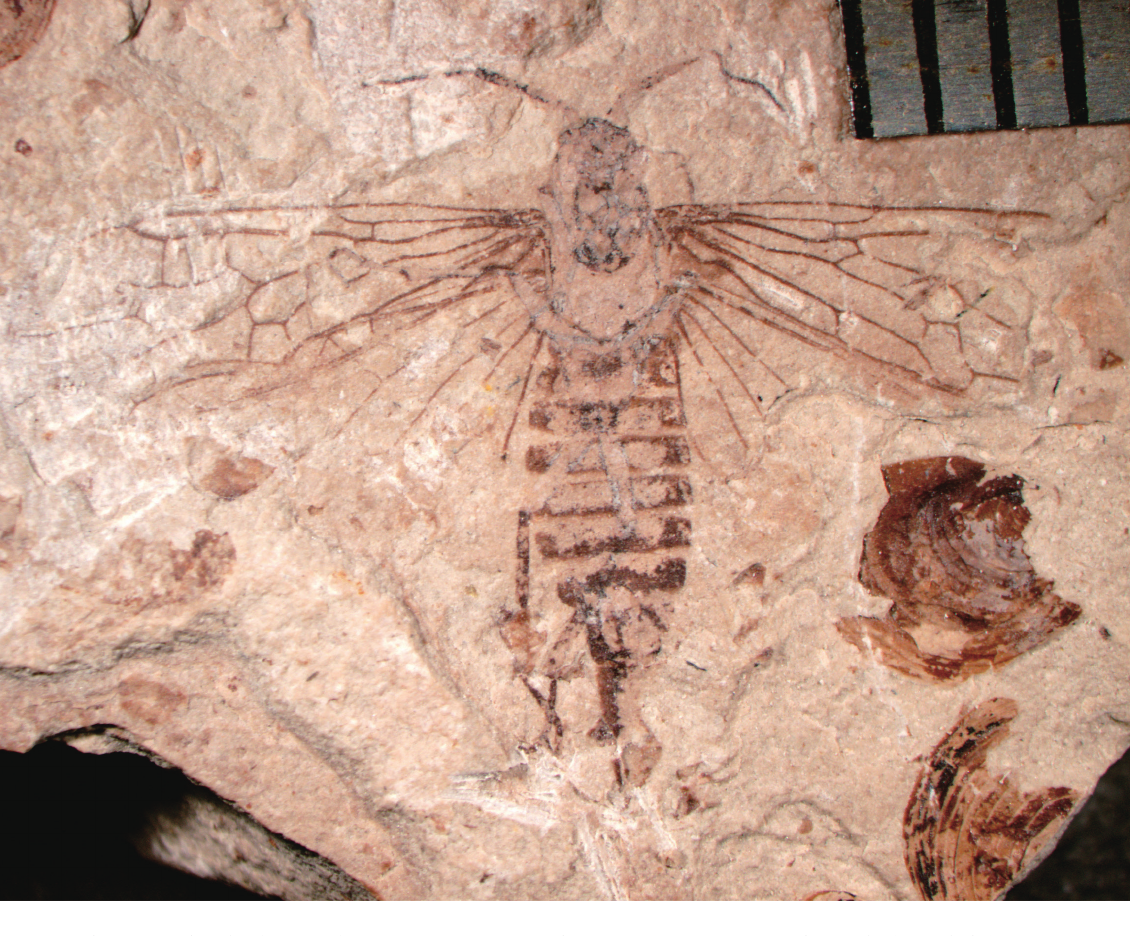
Fig. 2. Photograph of Platyxyela tenuis sp. nov. Holotype, NND0176. Ruler unit (top right): 1